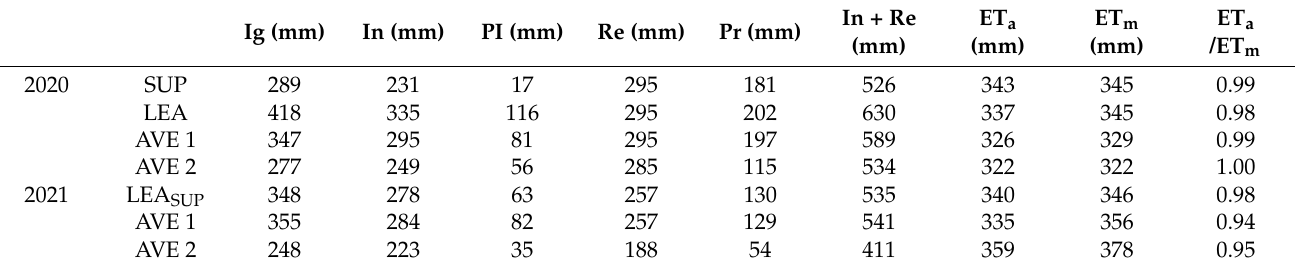
Table 7. Total water received by the crop, percolation and ET a /ET m ratios reached at each garlic growth